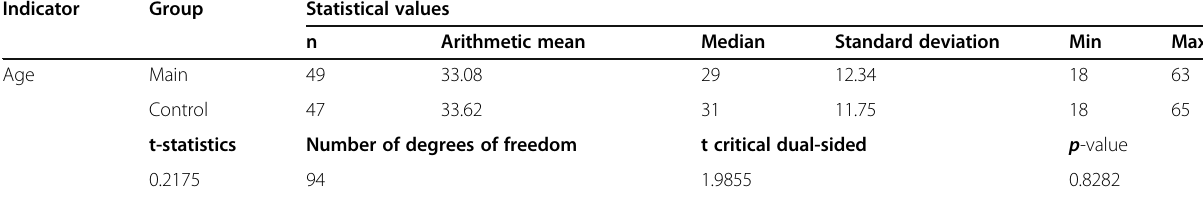
Table 3 Age distribution of the patients